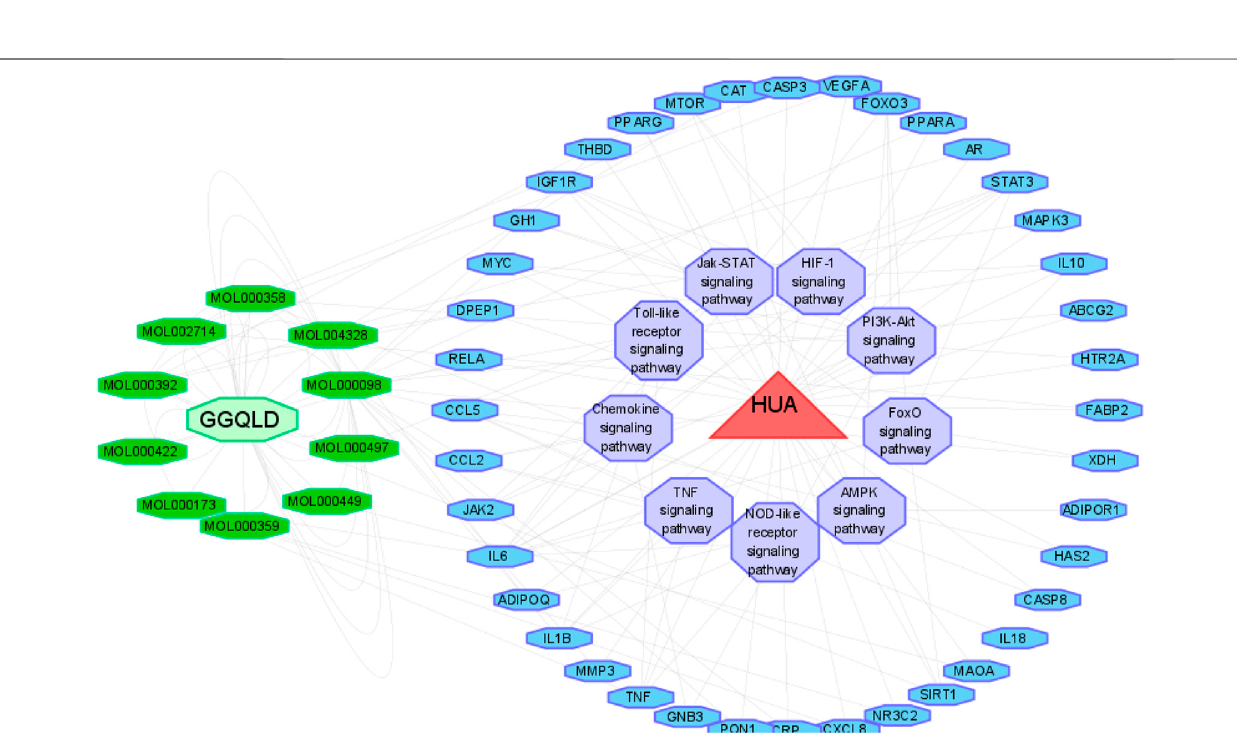
Frontiers in Pharmacology |